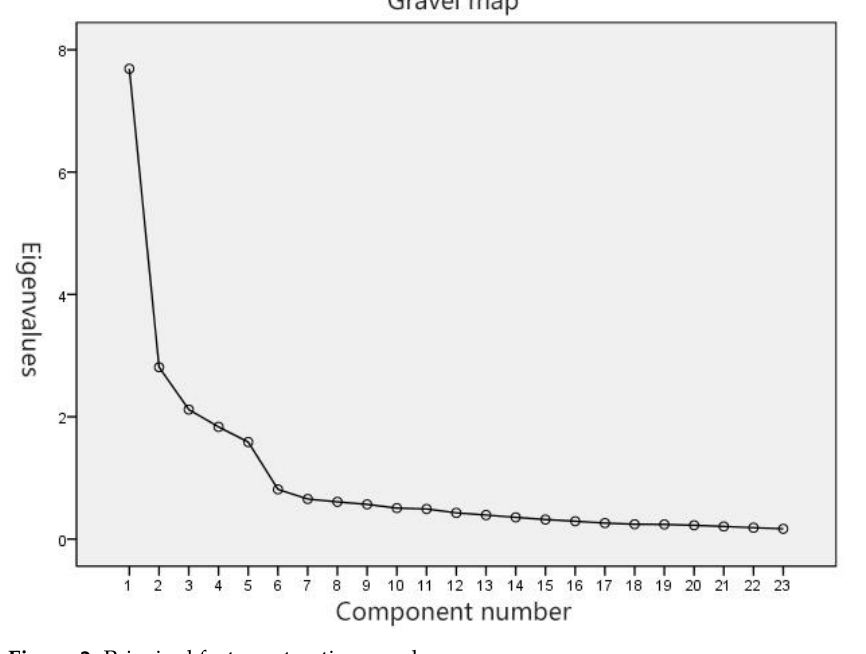
Figure 2. Principal factor extraction graph. Table 2. Extraction results of satisfaction evaluation